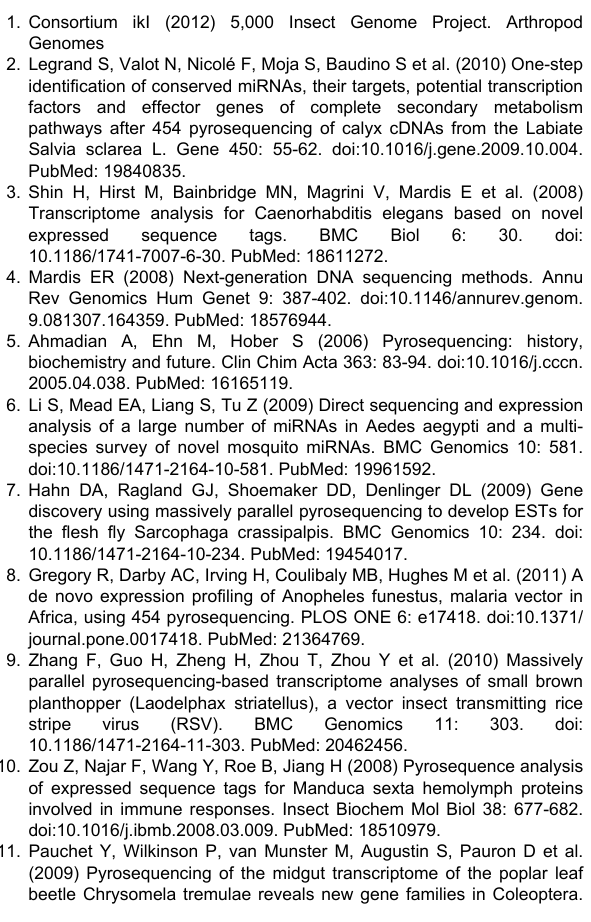
Figure S2. E-value for the top BLASTx hits. Sequences with e-value equal to 0 are represented in a peak at right. 84.9% of the contigs showed significant blast matches at a cutoff e-value ≤ 10 -3 .